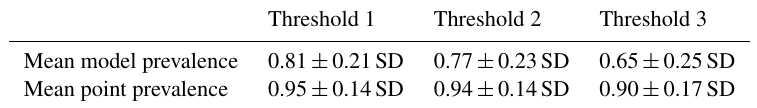
Table 1. Mean model and point prevalence for AOH maps with standard deviation of 4889 bird species across 3 different thresholds.